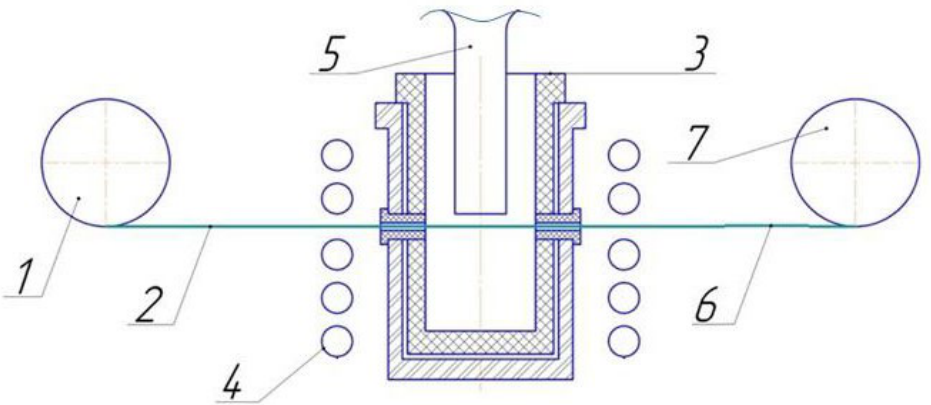
Figure 1. Scheme for obtaining a CF/Al-Sn-wire.